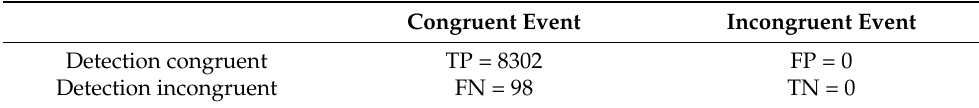
Table 12. Contingency table that assists with the detection of congruences in the Landsat 8 scene of the Doce River basin acquired in 2020 and consisting of 8400 tiles (TP—true positive, FP—false positive, FN—false negative, TN—true